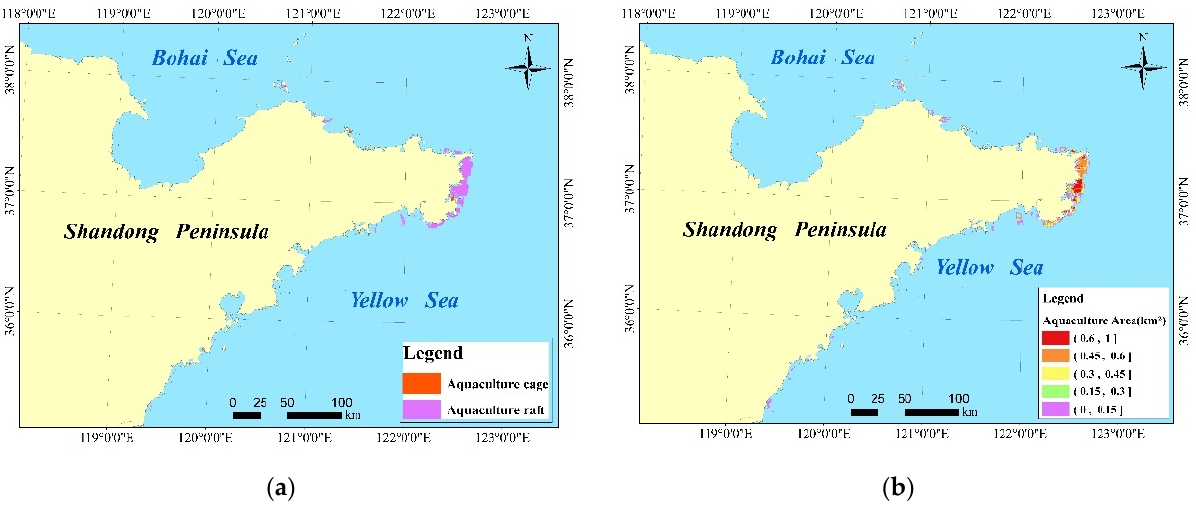
Figure 7. Aquaculture areas extracted from Landsat 8. ( a ) Classified by aquaculture type; ( b ) Classified by aquaculture density.